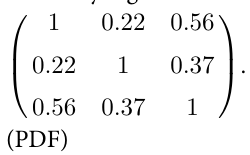
S8 Fig. Resulting species compositions from 5,000 simulations with large interspecific interactions. In Panel A , species 3 has strong harmful effects on species 1 and 2. In Panel B , all three species have strong harmful effects on each other. In Panel C , species have either strong harmful or strong beneficial effects on each other. In the numerical settings of all cases, the total time is 200, step size is 0.01 and extinction threshold is 10 − 6 . The simulations are con- ducted by the Runge-Kutta method. As a reference, the interaction matrices in Panels A, B, and C are respectively. Also, the three systems here are not globally stable. S9 Fig. Cartographic representation of long-term and short-term differences among pair- wise coexistence within the same 10-species system. Panels A and C show the system-level effects on 45 pairs within a randomly-generated ten-species system characterized by negative- dominated and positive-dominated interactions, respectively (see Fig 2). Rows correspond to the projection distribution ( PC ð Z ; S Þ ), long-term effects ( LE ð Z ; S Þ ), short-term effects ( SE ð Z ; S Þ ), and buffering effects ( BE ð Z ; S Þ ), respectively. Note that each point in the distribu- tions is a different pair within a system. For reference, the dashed line shows the value of 1. Recall that the x-axis corresponds to the change in probability of pairwise coexistence within the system. Panels B and D illustrate the cartographic representation for all corresponding pairs based on beneficial ( LE ð Z ; S Þ > 1 ) or detrimental ( LE ð Z ; S Þ < 1 ) long-term effects and beneficial ( BE ð Z ; S Þ < 1 ) or detrimental ( BE ð Z ; S Þ < 1 ) short-term effects. The size of points corresponds to the feasibility of pairs in isolation. The number of points in each region is annotated in gray. S10 Fig. Buffering effects obtained by simulating dynamics over time. As time increases, the distribution of buffering effects (y-axis) of the system on pairwise coexistence gradually shifts to a position centered at zero. The shift is faster and smoother as the number of simula- tions increases (Panel A : 250 simulations; Panel B : 3000 simulations). In the numerical settings of both cases, the size of time step (x-axis) is fixed as 0.01 and the extinction threshold is 10 − 6